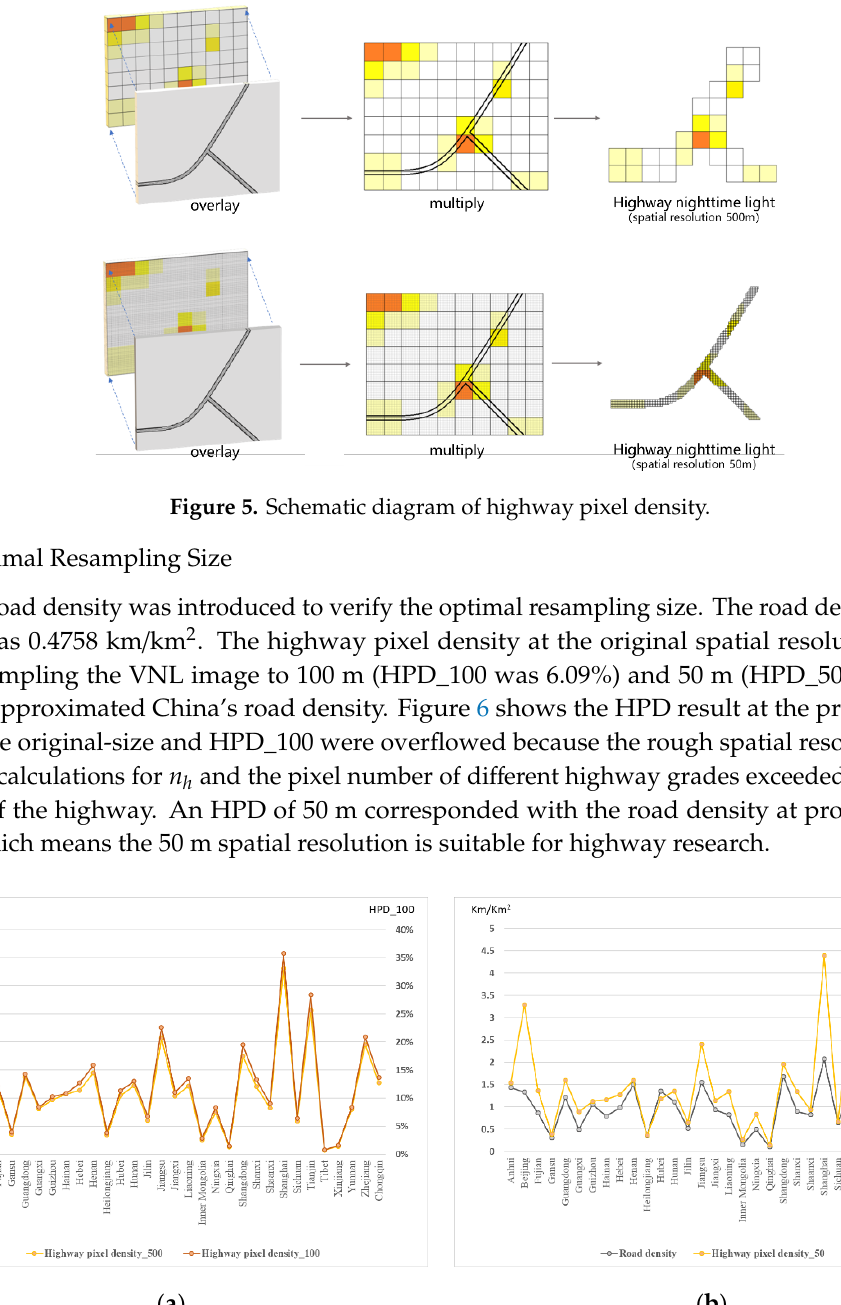
Table 2. The statistics information of resample results at different spatial resolution.